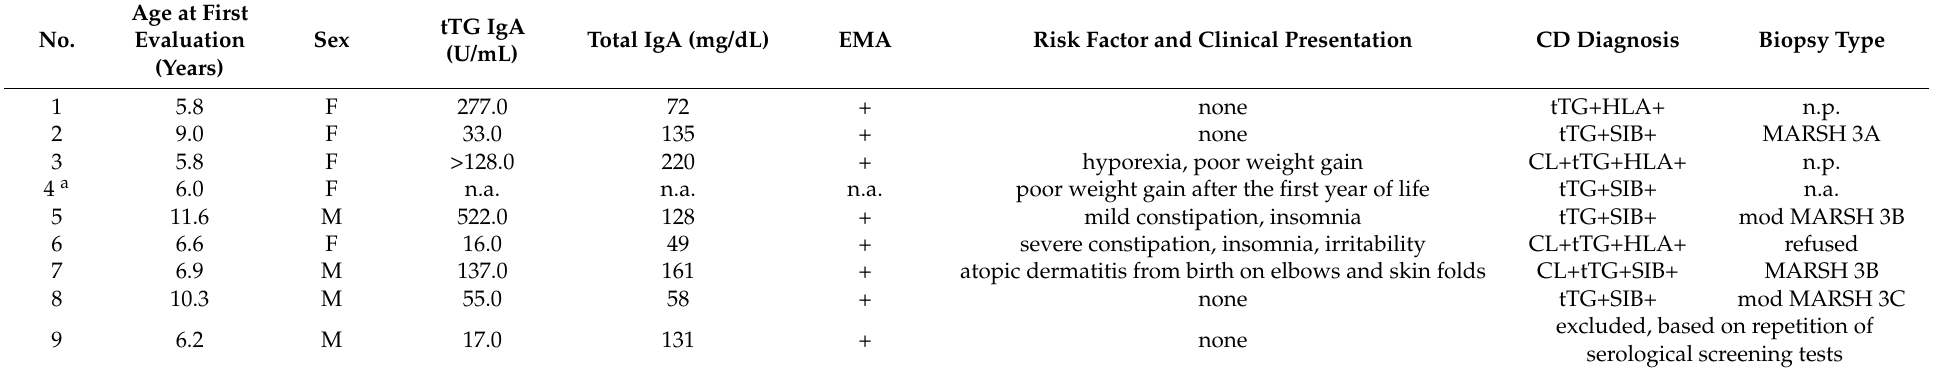
Table 1. Biological findings and clinical characteristics of the nine ASD subjects with CD or positive CD